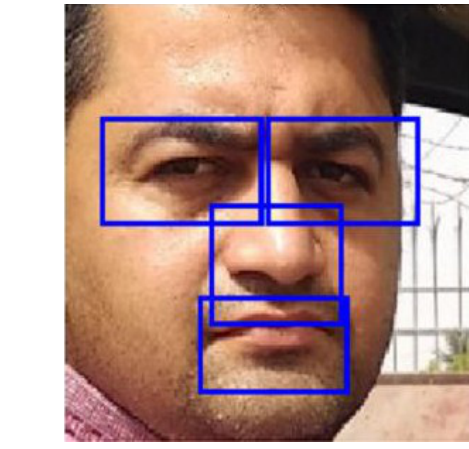
FIG. 4. (a) INPUT IMAGE FOR FACIAL RECOGNITION OF M. SHAFIQ